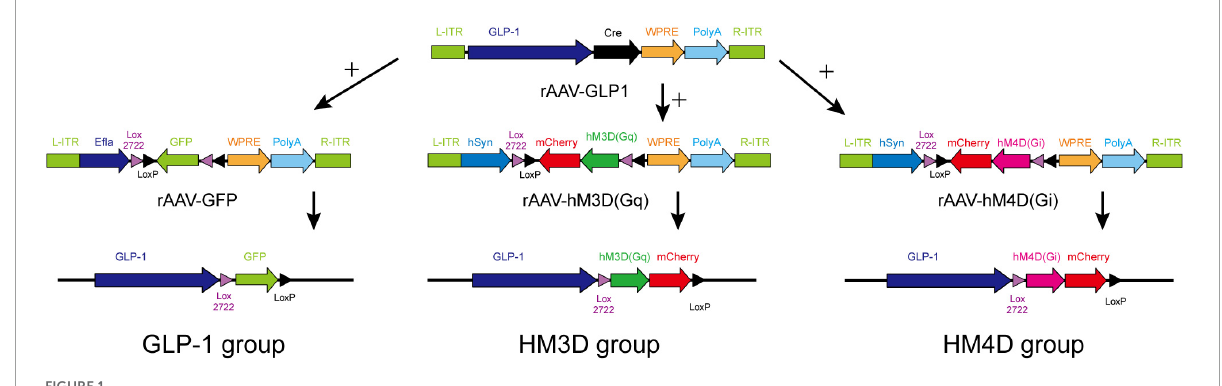
FIGURE1 Gene sequence and combinatorial strategy of